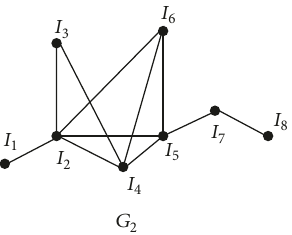
Figure 3: A weighted interval graph 𝐺 2 with weights 𝑤(𝐼 1 ) = 2 , 𝑤(𝐼 ) = 1 , 𝑤(𝐼 2 𝑤(𝐼 ) = 2.2 8